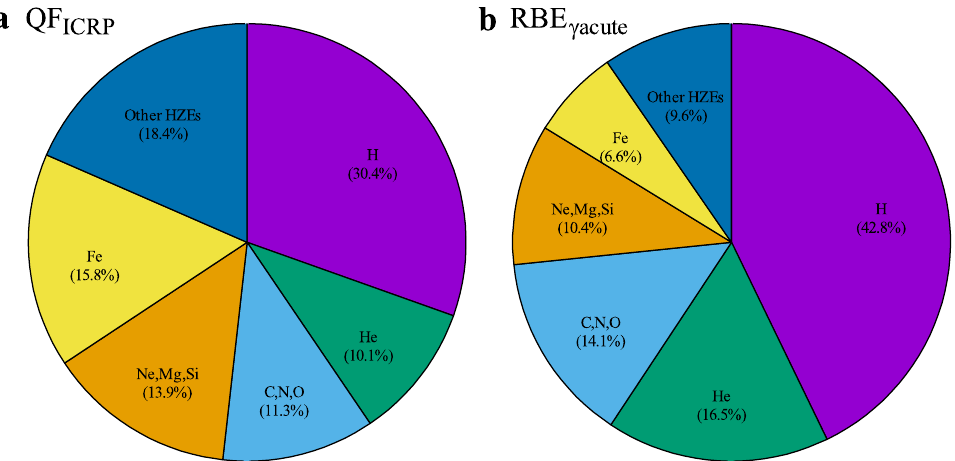
Figure 4. Contribution ratio of GCR particles to the effective dose equivalent. ( a ) QF ICRP and ( b ) RBE γacute in free space (with no shielding materials).